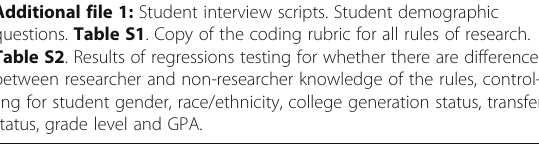
Table S2 . Results of regressions testing for whether there are differences between researcher and non-researcher knowledge of the rules, control- ling for student gender, race/ethnicity, college generation status, transfer status, grade level and GPA.